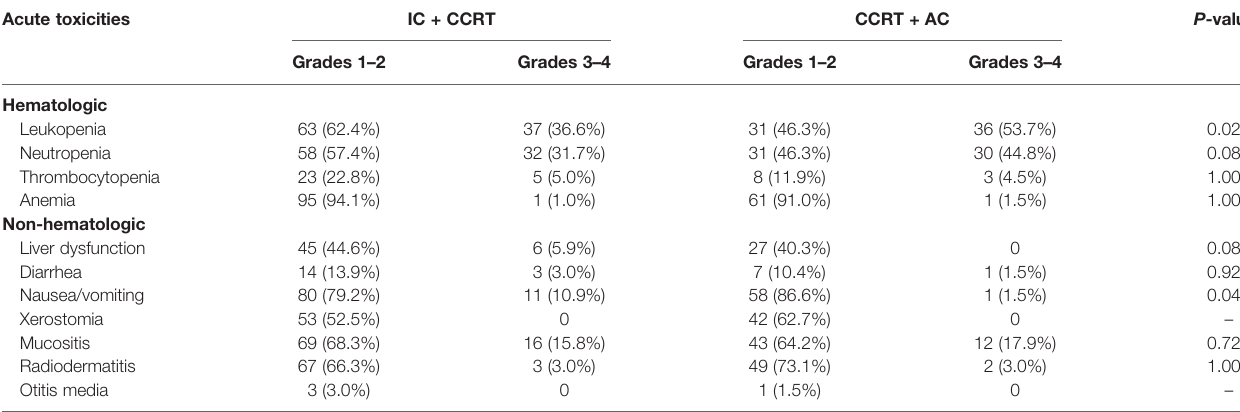
TABLE 4 | Treatment-related acute toxicities in NPC patients treated with IC + CCRT vs. CCRT + AC after PSM.